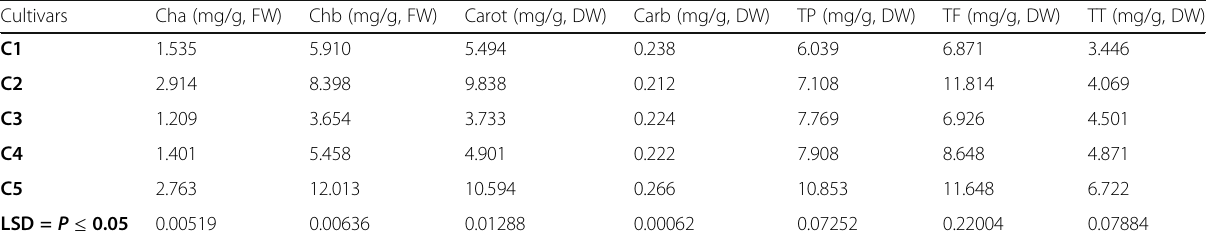
Table 1 Different cultivars affect the chemical analysis of Coleus blunei (mean of two seasons) Cultivars